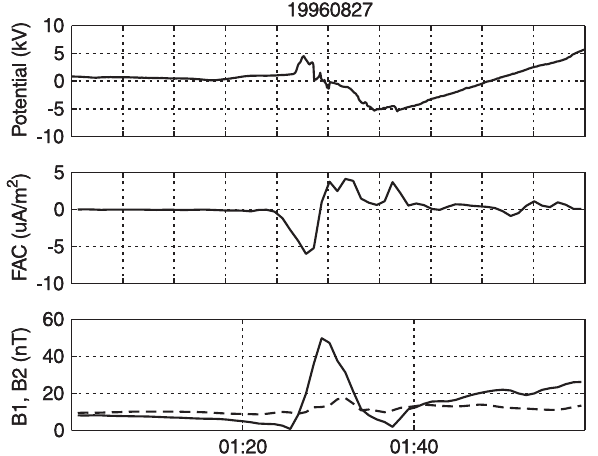
Fig. 4. Event 9608827 01:25–01:35 UT (the BEF category). Since B is smaller than B , the FAC estimate should be rather reliable. The 1 potential has the wrong sign to support the upward extended U- shaped potential picture